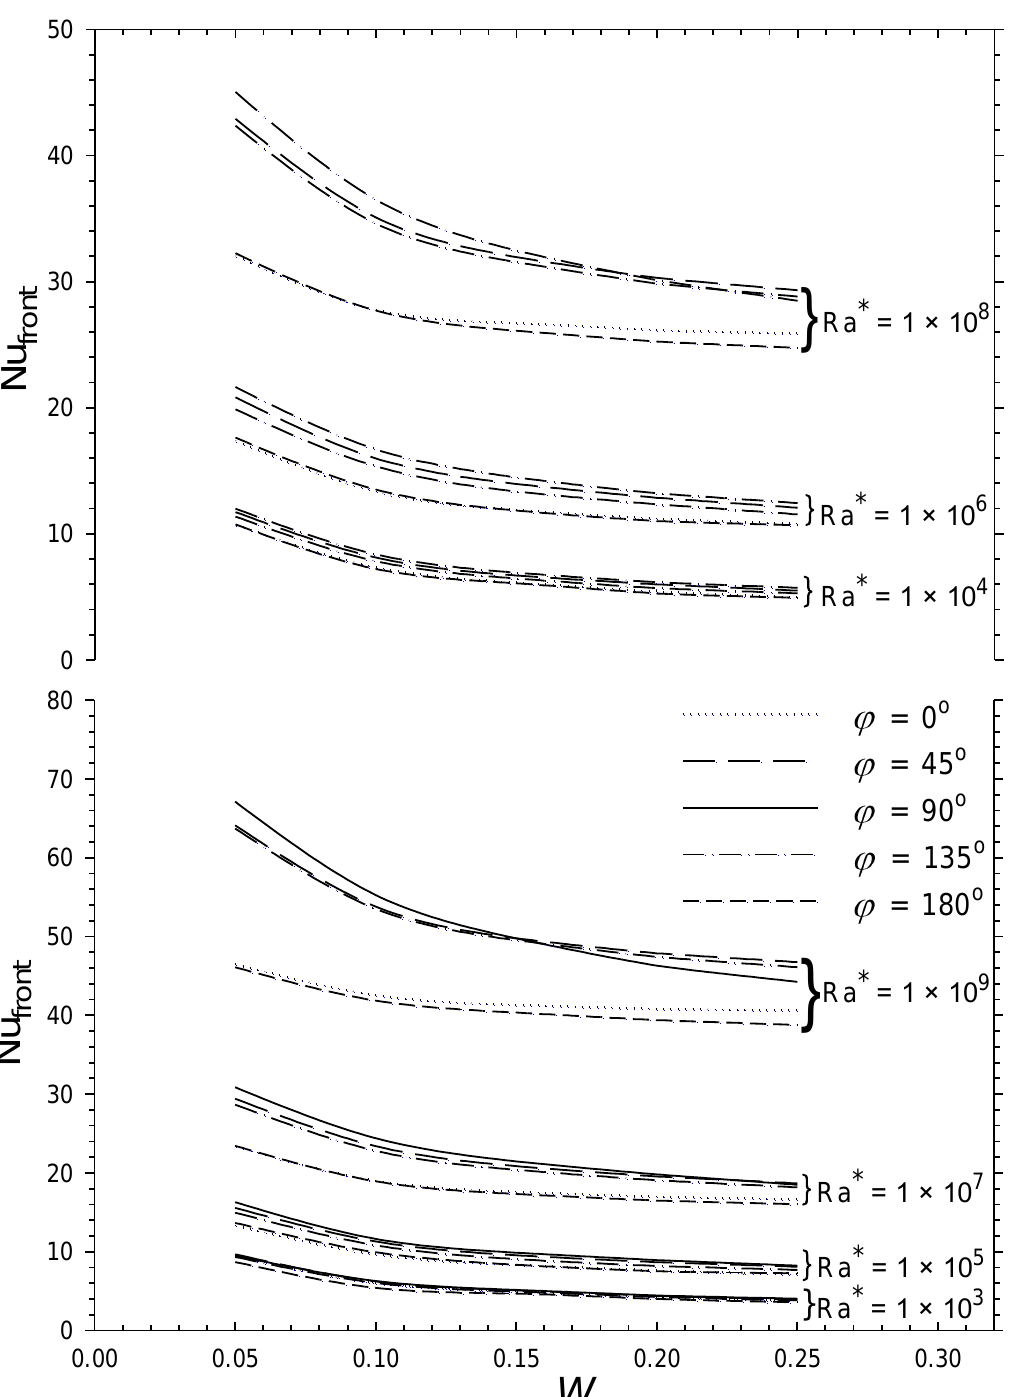
Figure 9. Variations in the mean Nusselt number of the front surface of the slender cuboid with dimensionless width, W , for different values of the heat flux Rayleigh number, Ra *, and positions, φ .